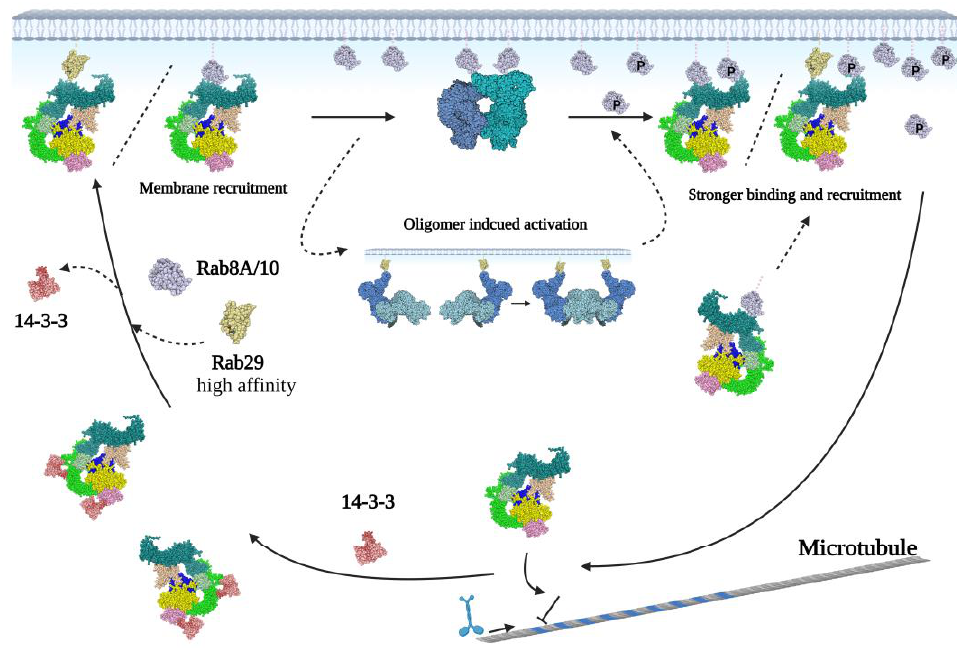
Figure 5. Proposed model of the LRRK2 activation cycle. LRRK2 is mainly monomeric in the cytosol, a conformation that is stabilized by binding to 14-3-3. Binding of Rab proteins to the ARM domain can induce recruitment of LRRK2 to membranes, where the high concentration of LRRK2 facilitates oligomerization and activation. Subsequently, the phosphorylated substrates, Rab8 and Rab10, can bind to the ARM domain to strengthen the LRRK2 membrane binding, thereby prolonging LRRK2 activation. (LRRK2 is indicated by AlphaFold2 model with: ARM in dark green, ANK in light green, LRR in green, Roc in pink, COR in yellow, kinase in blue, and WD40 in light yellow. The membrane-bounded dimeric/oligomeric protomers are indicated with blue or cyan) .